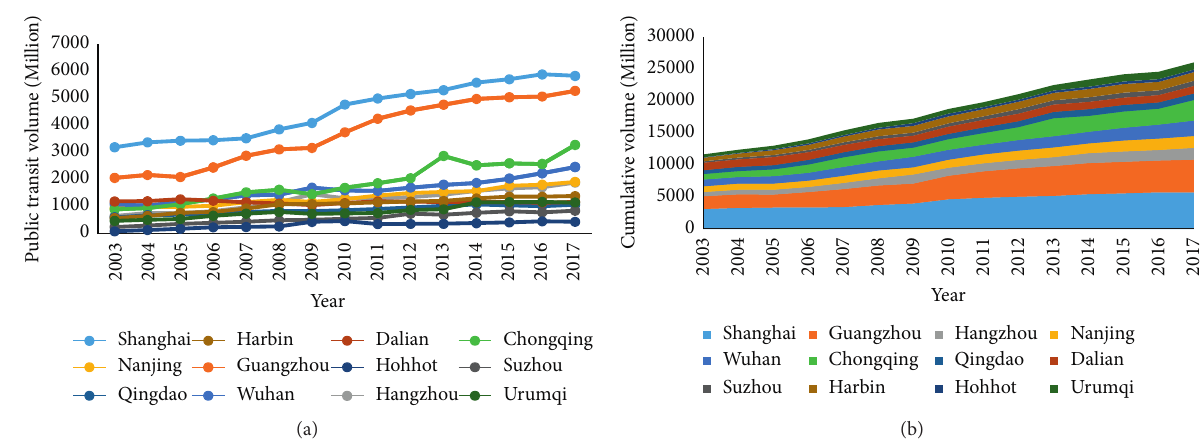
Figure 1: The passenger volume of public transport in large cities. (a) Passenger volume, (b) cumulative passenger volume.